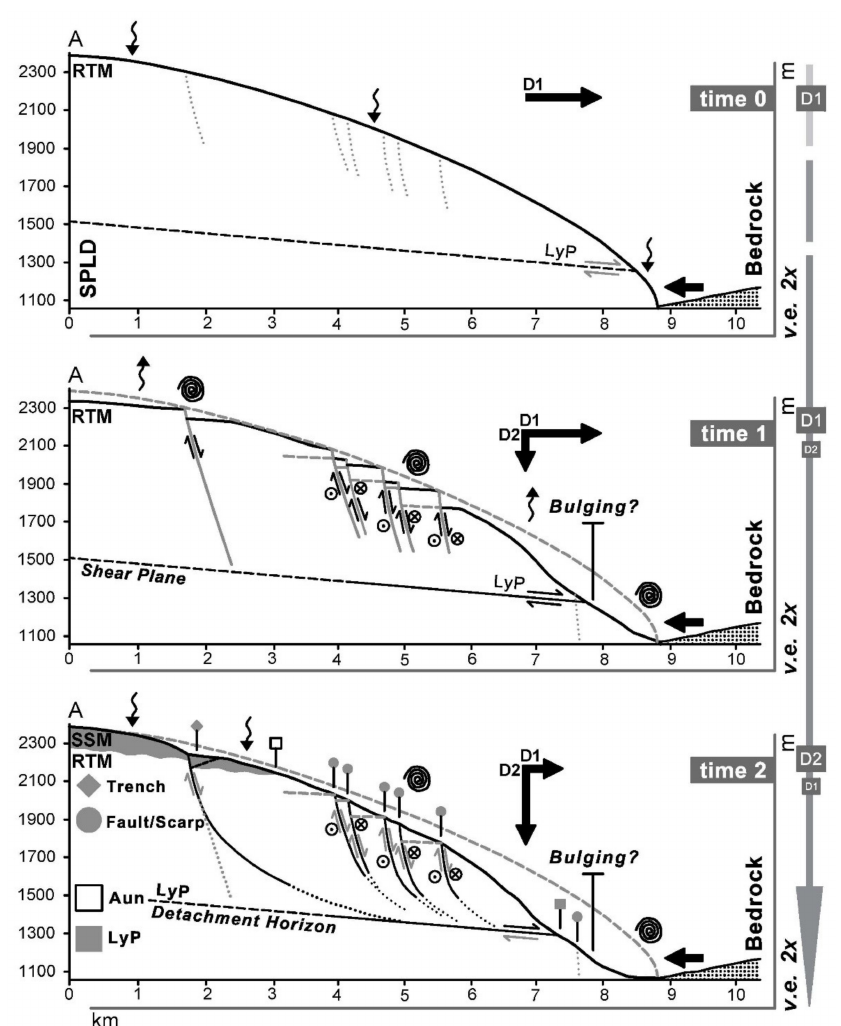
Figure 8. Possible geological evolution of one deformational system in Promethei Lingula, which shows the evolution of DSGSD and the role of pre-existing structures; redrawn after Guallini et al. [68]. The gravitational morpho-structures (black lines) are supposed to re-activate the pre-existent fault planes (grey lines). The LyP and bounding layers activate (and/or are activated by) the gravitational movement, and, therefore, they act as detachment